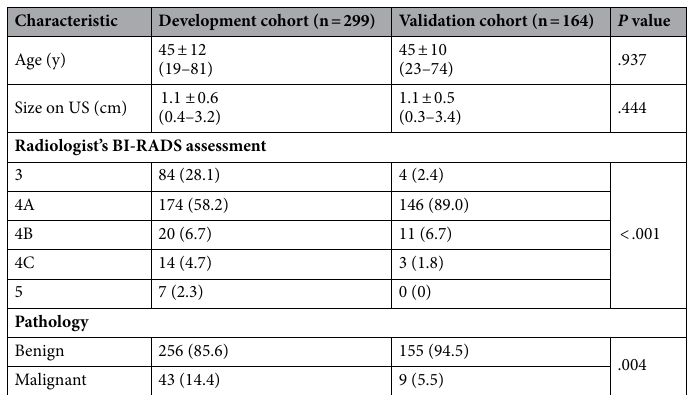
Table 1. Characteristics of the development and validation cohorts. BI-RADS, Breast Imaging Reporting and Data System. Data for the age and size are expressed in terms of the mean ± standard deviation (ranges). Data for the BI-RADS final assessment and pathology are presented as numbers